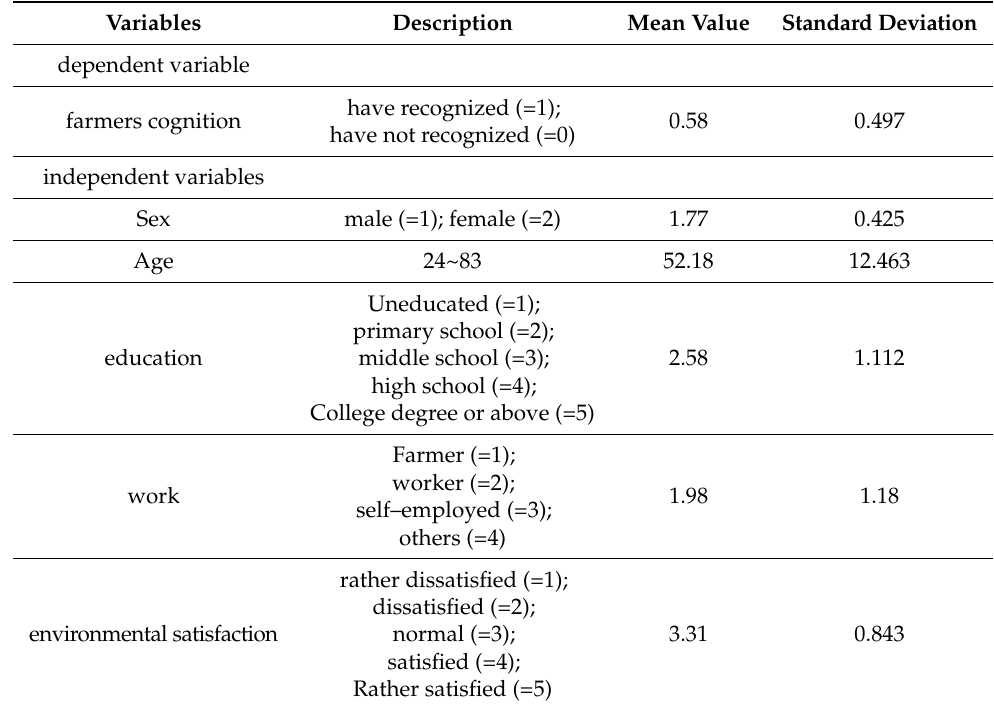
Table 1. Variable descriptive statistics in Binary Logistic regression model. Variables Description Mean Value Standard